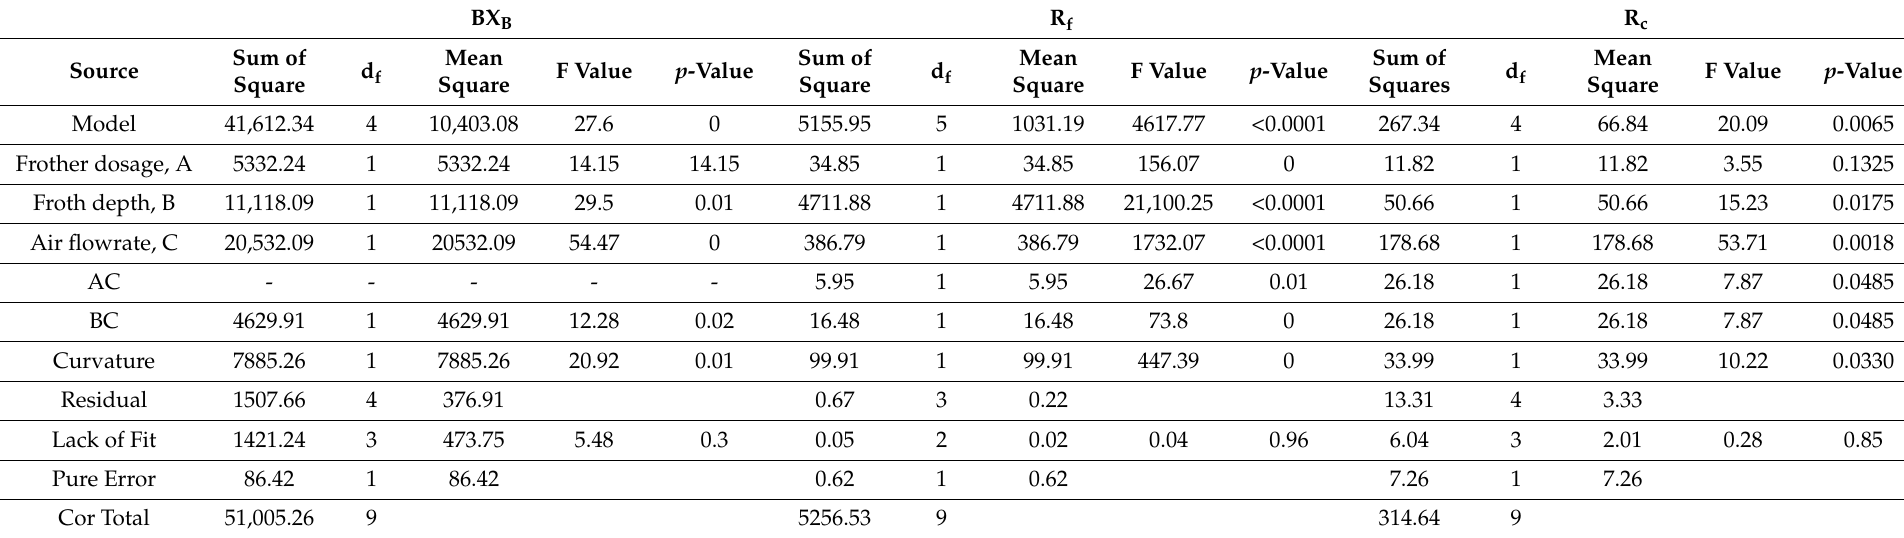
Table 2. The variance analysis of effective parameters on flowrate of the minerals into the froth phase (BX B ), froth recovery (R f ), and collection zone recovery (R c